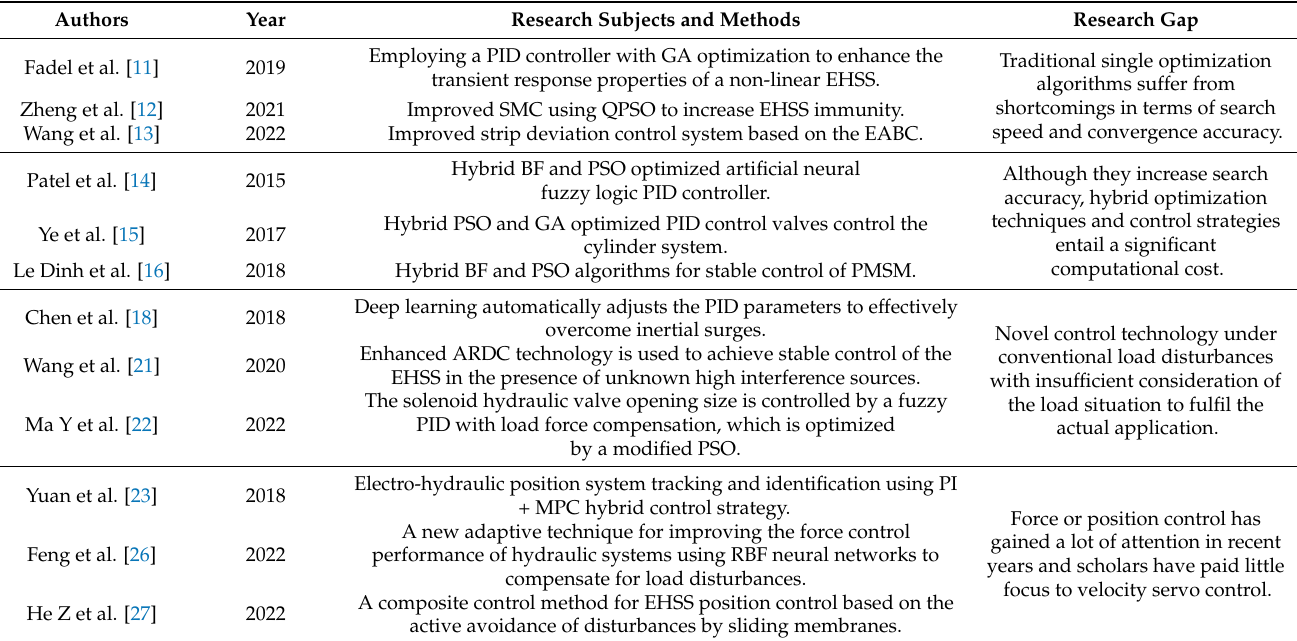
Table 1. The summary of research gaps in published primary